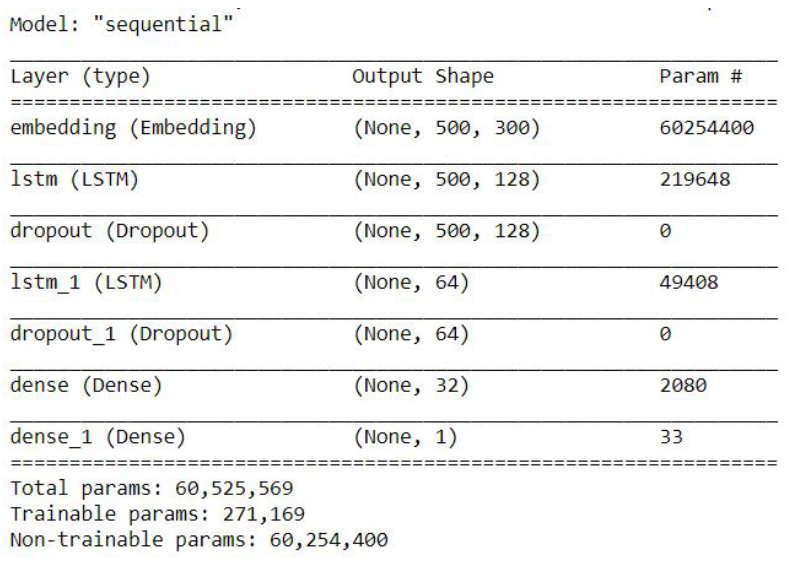
Figure 7. LSTM Model.